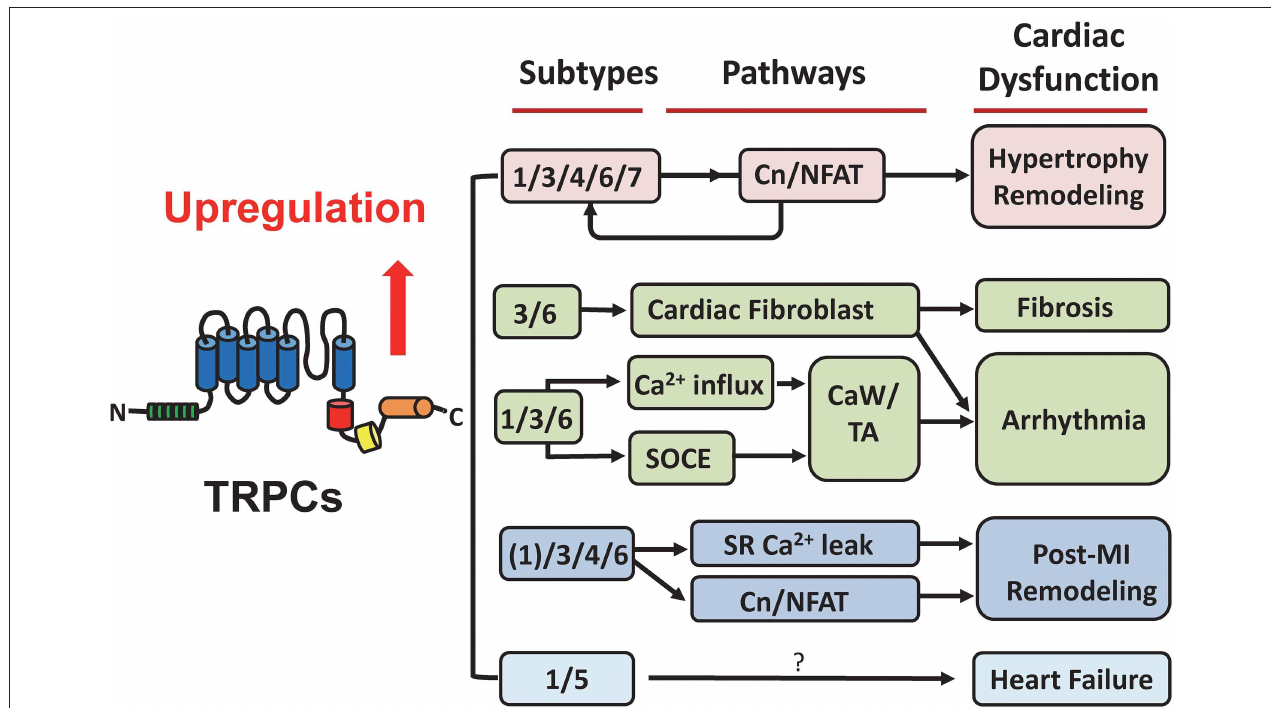
FIGURE 2 | Summary of TRPC-associated cardiac dysfunction. TRPCs have been recognized as considerable mediators in the heart under pathological conditions. This suggests their potential in developing targeted drugs for cardiac diseases. The participation and underlying pathways of different TRPC subtypes in hypertrophic remodeling, fibrosis, arrhythmia, post-myocardial infarction remodeling, and heart failure are illustrated. See details in the main text. Cn/NFAT, calcineurin/nuclear factor of activated T cells; SOCE, store-operated calcium entry; CaW, calcium waves; TA, triggered activities; MI, myocardial infarction.